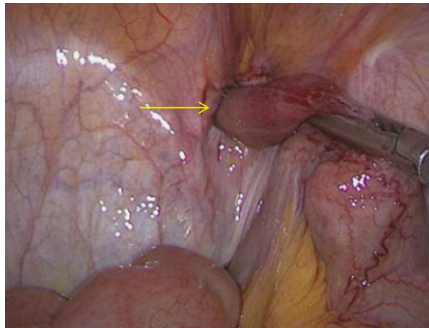
Figure 1: The incarcerated insu ffi cient blood-supplied Meckel ’ s diverticulum is marked by the yellow arrow.